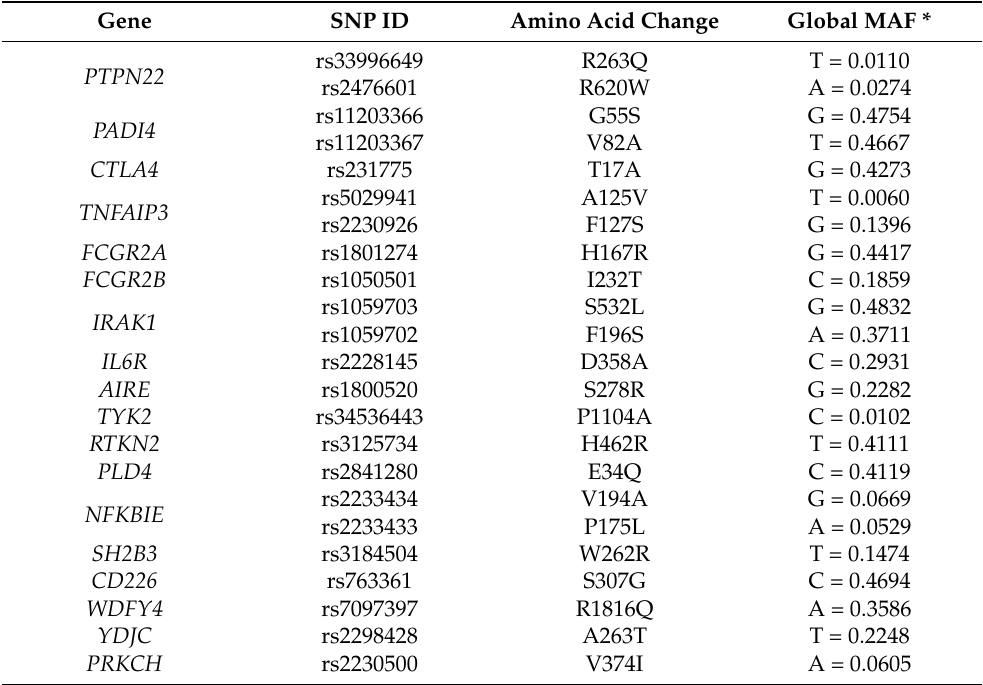
Table 1. nsSNPs along with amino acid change and global MAFs associated with